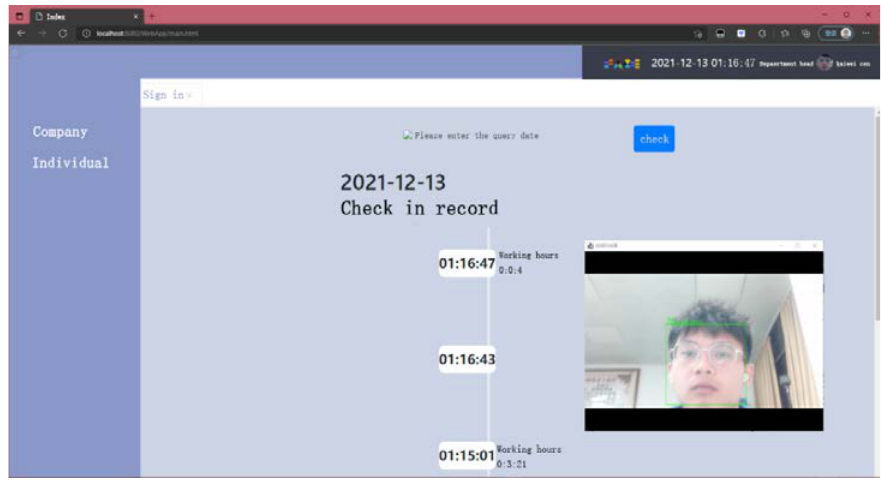
Fig. 2. Punch card